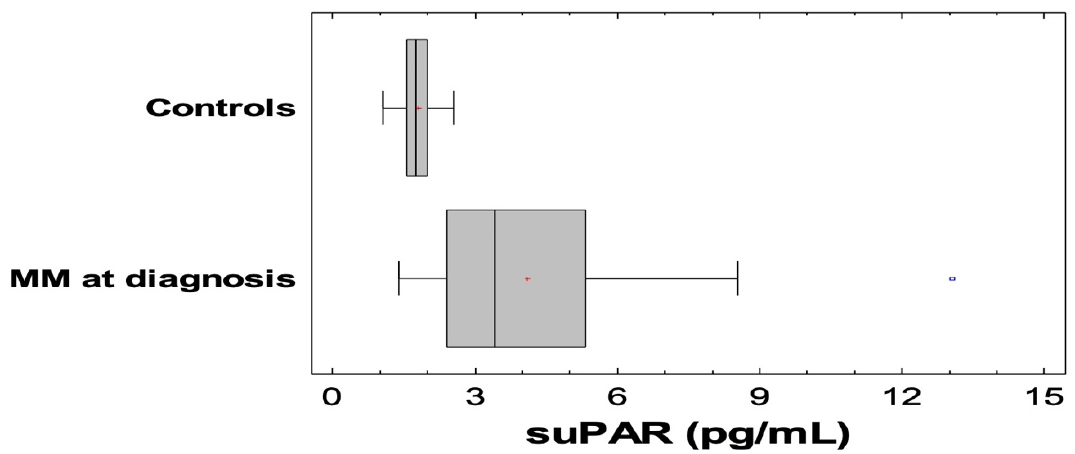
Figure 1. Soluble urokinase-type plasminogen activator receptor (SuPAR) levels were significantly elevated in newly diagnosed patients with symptomatic multiple myeloma (NDMM) patients compared to controls ( p < 0.001).